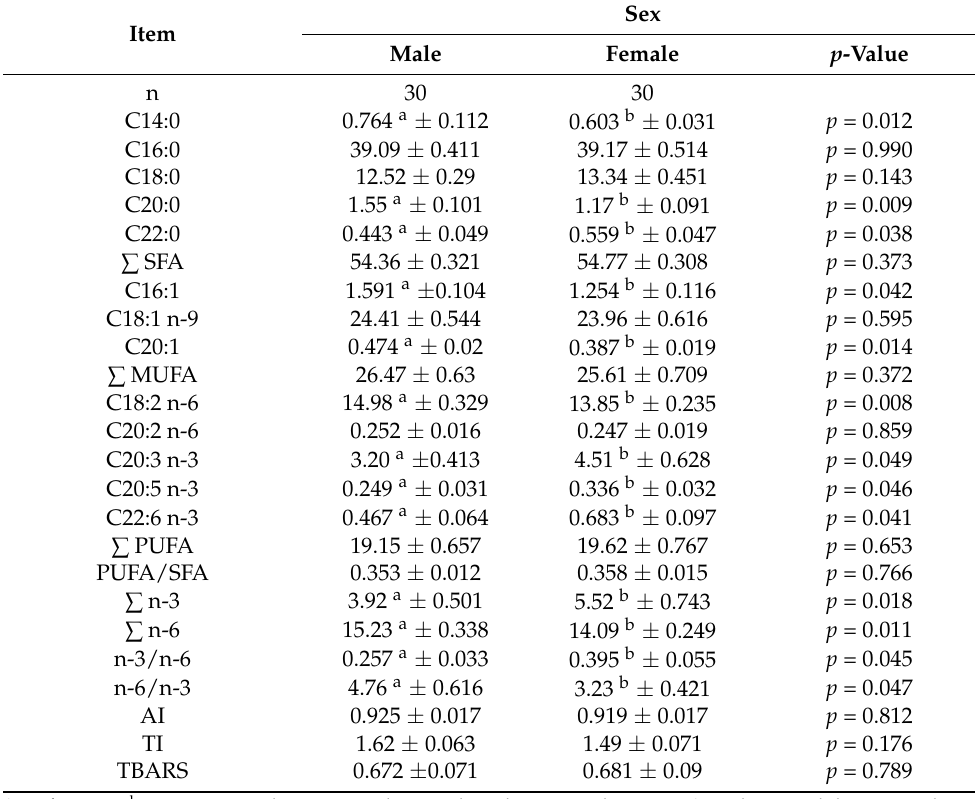
Table 4. Effect of sex on the content of fatty acids (% of total acids) and oxidative stability (mg MDA/kg) in pectoral muscles from broilers reared in an organic system at 82 days (mean values ± SD). Sex Item Male Female p